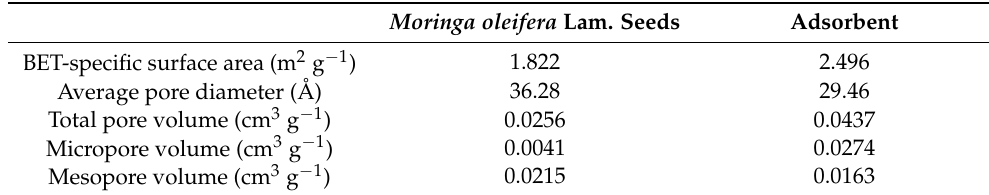
Table 1. Texture properties of Moringa oleifera Lam. seeds and of the synthesized low-cost adsorbent. Moringa oleifera Lam. Seeds